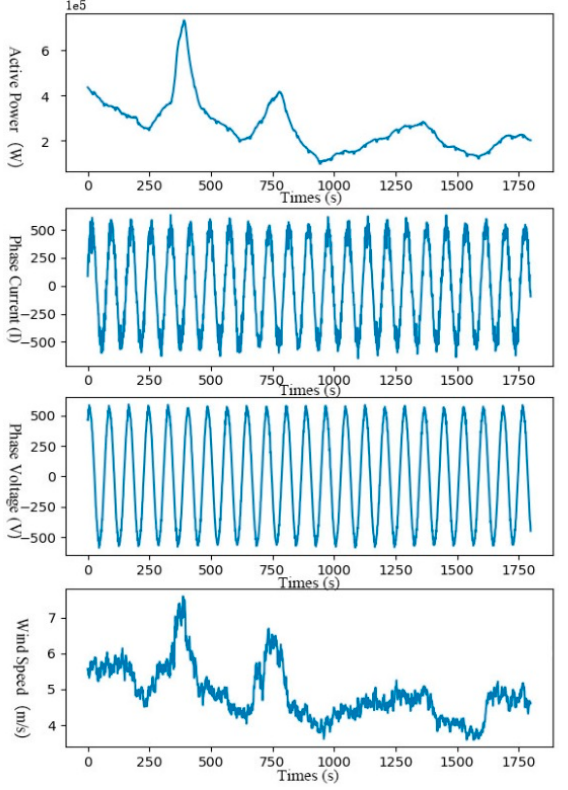
Figure 8. Waveform of raw data.